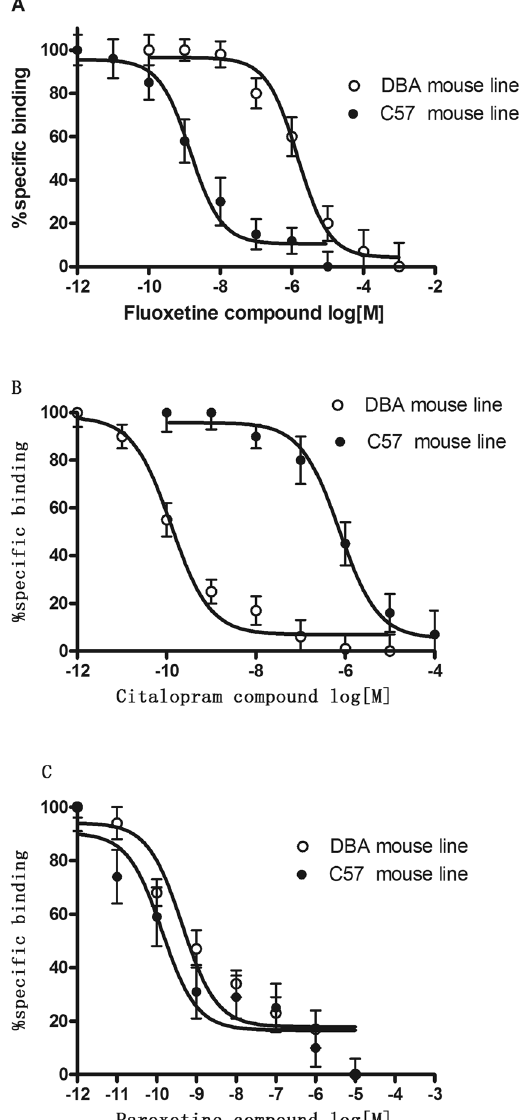
Figure 5. Fluoxetine ( A ), citalopram ( B ) and paroxetine ( C ) compete for 5-HT transporter binding (specific [ 3 H]paroxetine binding) in the two mouse strains. The IC 50 value was generated from each of these curves. Each data point depicted represents the mean ± S.E.M. of 3–4 mice. The IC 50 value for fluoxetine, citalopram and paroxetine are shown in Table 1.